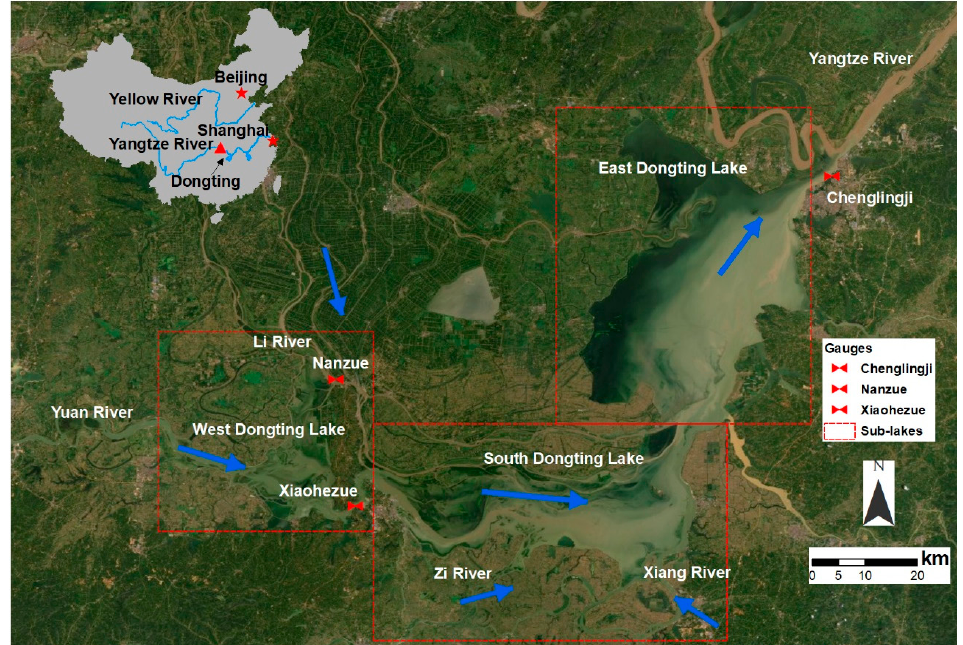
Figure 1. Map of Dongting Lake. Blue arrows indicate the approximate flow direction. Inset shows the Dongting Lake in relation with the Three Gorges Dam (red triangle) and the Yangtze River, China. Background aerial photo source: ESRI (http://services.arcgisonline.com/arcgis/rest/services).